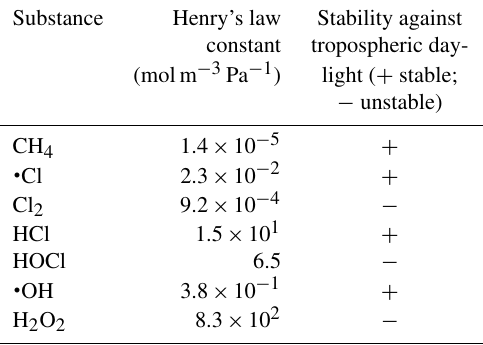
Table 1. The Henry’s law constants (Sander, 2015) and daylight stability for different gaseous or vaporous components reacting with or produced by ISA in the